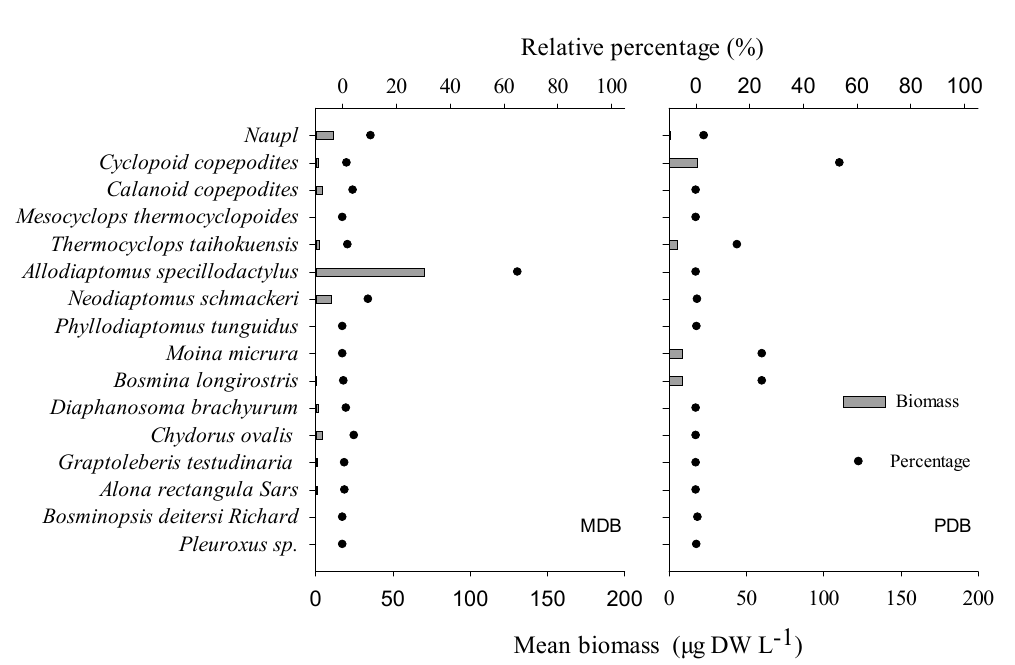
Figure A1. Mean biomass and relative percentage of crustacean zooplankton taxa in MDB and PDB during the period April 2010–March 2011.